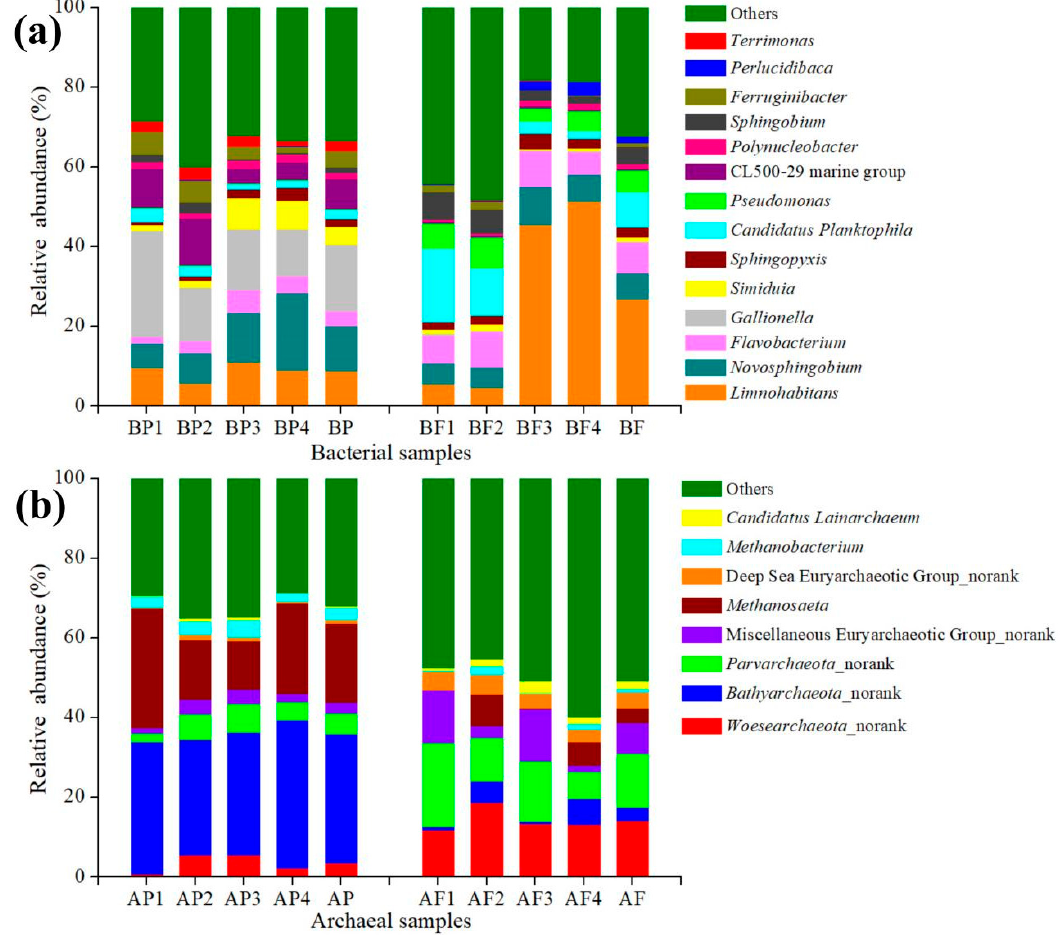
Figure 3. Distributions of genus-level taxa for bacterial ( a ) and archaeal ( b ) samples. Bars represent the proportion of sequences represented by each genus. Bacterial taxa represented by less than 2% reads are pooled as “others”. The designation “norank” means that the specific archaeal taxa cannot be classified at the genus level. The proportion of each sequence in two size fractions is the mean value of quadruplicate analyses. BP, BF, AP and AF represent the average values of BP1–BP4, BF1–BF4, AP1–AP4 and AF1–AF4, respectively.